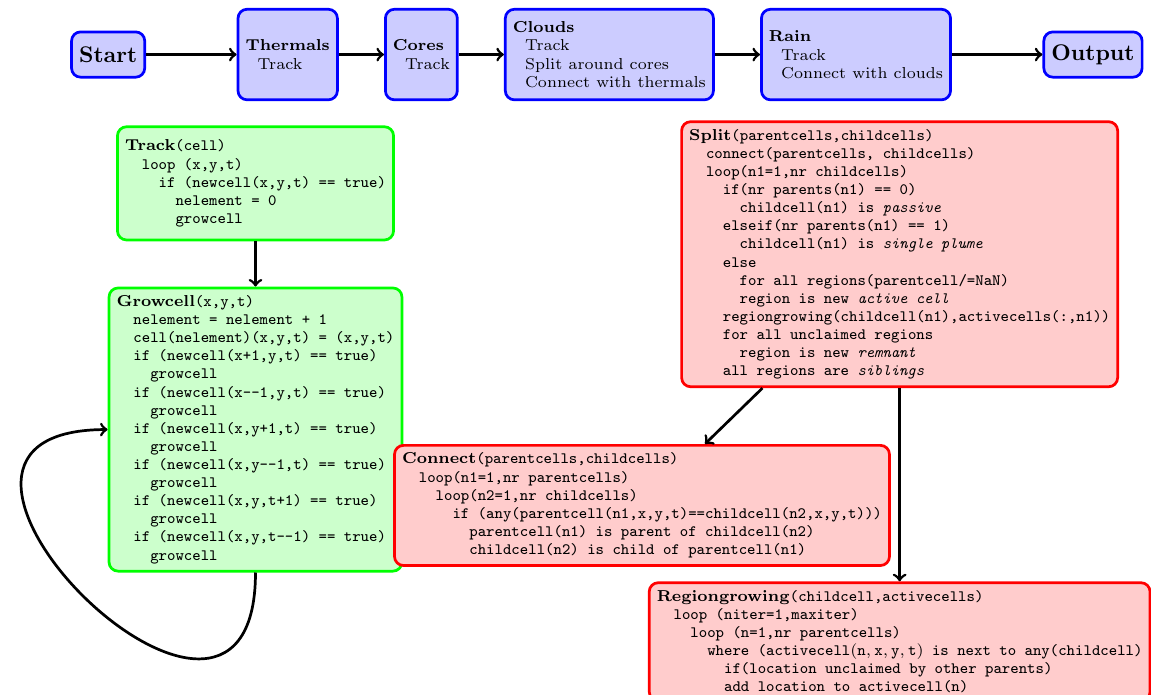
Fig. 1. Flowchart of the tracking algorithm in pseudo code. Tracking is first performed for thermal, then for cloud cores, clouds, and rain using a recursive cell growing method. Additionally, clouds are being split into multiple cells when appropriate, and are connected to thermals and rain areas, respectively, that share the same location at some point in the lifetime of the cells. The splitting algorithm makes use of the connecting algorithm and of the region growth algorithm that is slightly different from the cell growth used for the